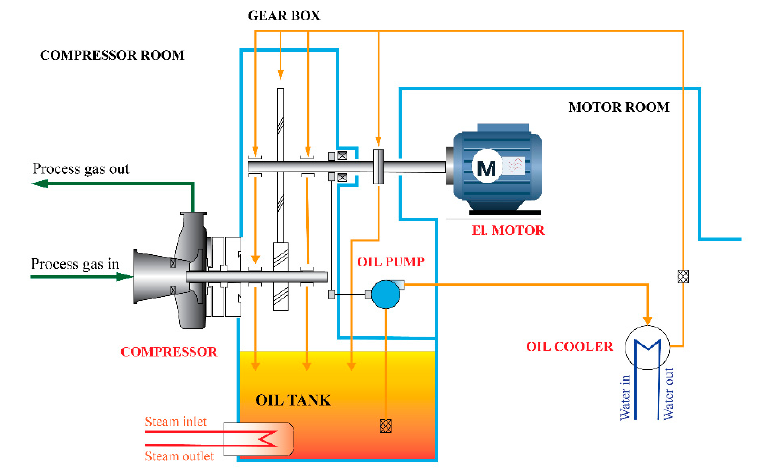
Figure 2. Scheme of low-duty turbo compressor with electric motor and reduction gear .